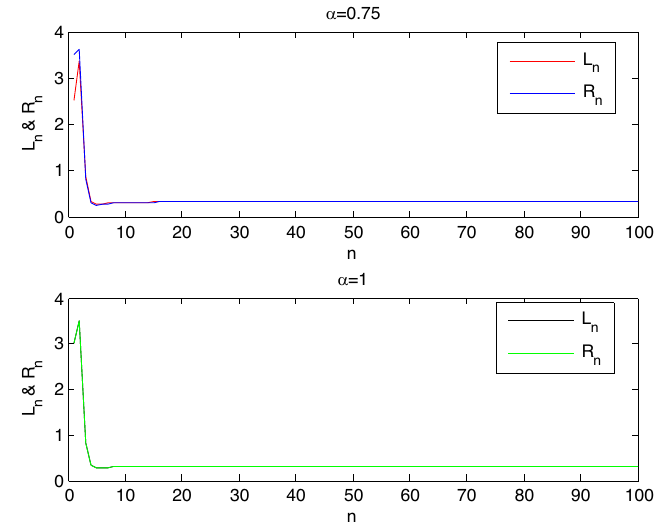
Figure 6: The solution of system ( 48 ) at = α 0.75 and = α 1 .